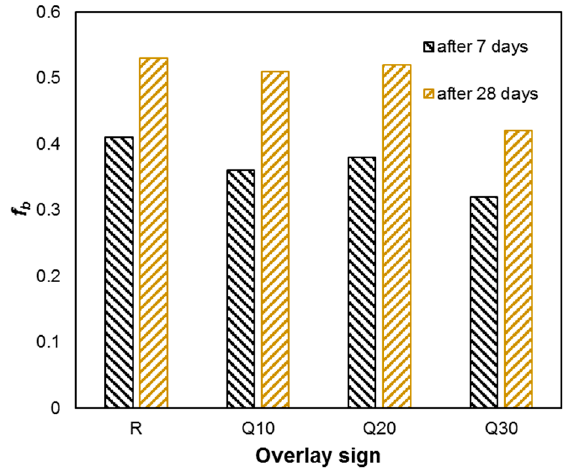
Figure 17. The influence of different amounts of quartz powder for modifying overlay concrete on the pull-off adhesion f b between the overlay and the concrete substrate (based on the results presented in Reference [74]).